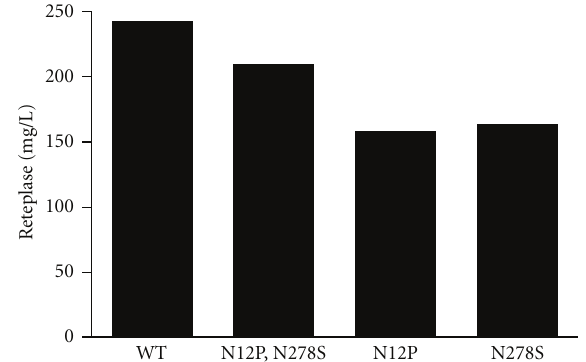
Figure 5: ELISA for rPA quantitation in Pichia fermentation super- natants. X axis shows sample types, Y axis is rPA concentration